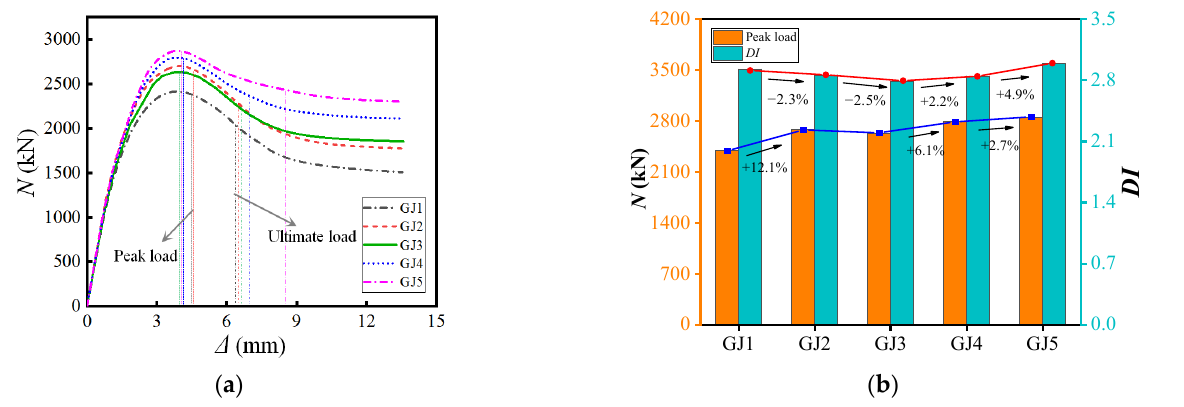
Figure 16. Different bar diameters. ( a ) Load–displacement curve ( b ) Performance Changes